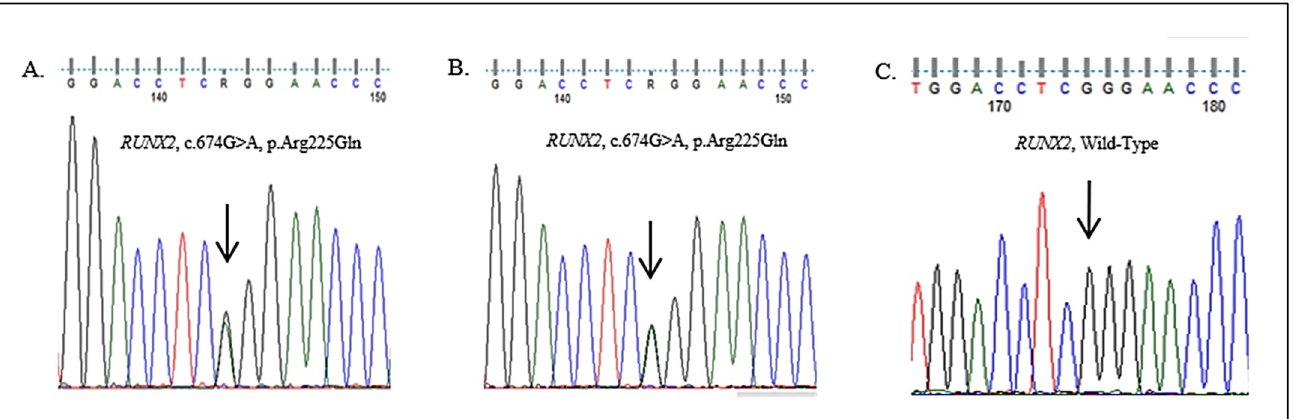
Figure 18. Sanger sequencing confirmation and segregation analysis of the RUNX2 mutation (NM_001024630.3:c.674G>A, NP_001019801.3:p.Arg225Gln), respectively, in the proband ( A ), the father ( B ), and the mother ( C ). The arrow points to the mutated nucleotide.